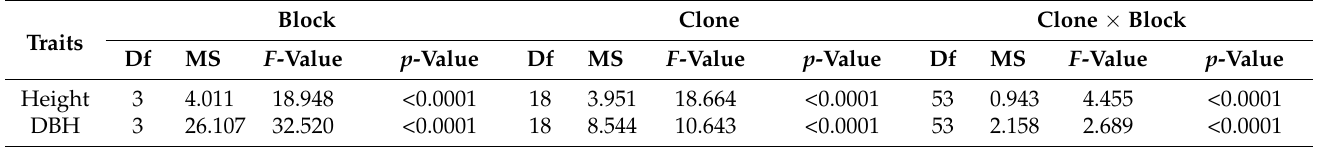
Table 2. Analysis of variance of growth